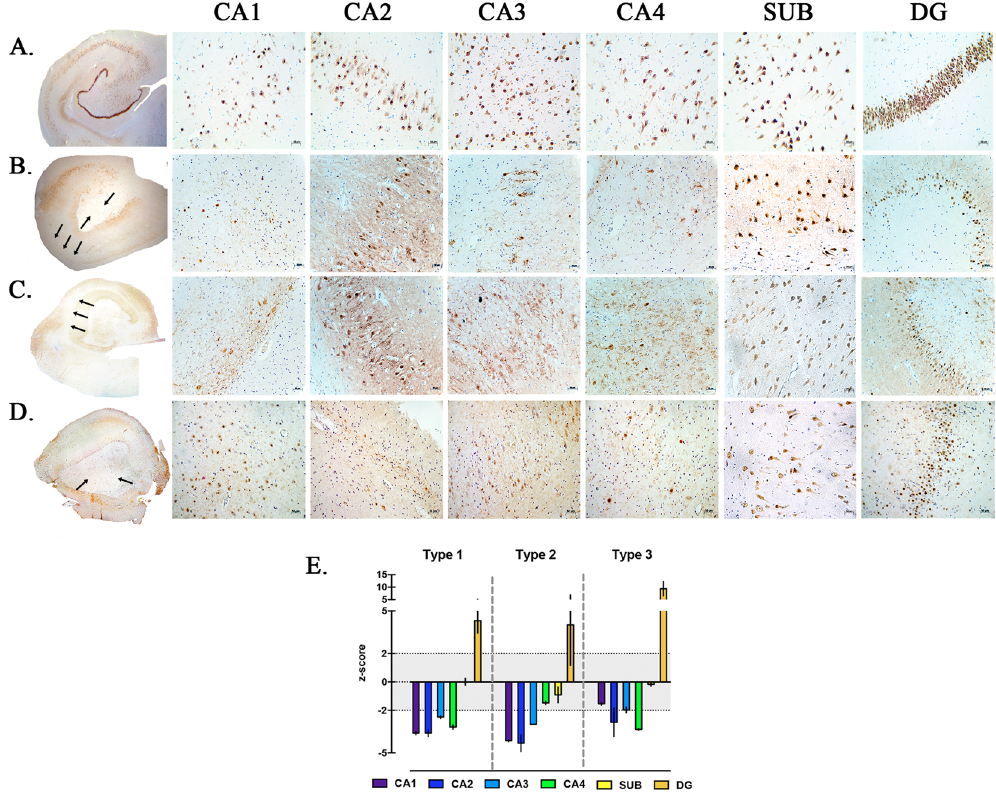
Figure 3. Histopathological patterns of hippocampal sclerosis. ( A – D ) NeuN immunostaining of neuronal nuclei. ( A ) No hippocampal sclerosis in control specimen obtained from autopsy without neurological disease. ( B ) ILAE hippocampal sclerosis type 1, note the marked neuronal loss in both the CA1 and CA4 subfields. ( C ) ILAE hippocampal sclerosis type 2, predominant cell loss in the CA1 area. ( D ) ILAE hippocampal sclerosis type 3, most restrict neuronal loss in the CA4 sector. Among all hippocampal sclerosis types, the histological pattern is variable in the dentate gyrus, wherein the granular cell loss and dispersion is predominant. Hippocampal subfields and the dentate gyrus were observed with a magnification of 20 × . Arrows indicate regions with severe neuronal loss. ( E ) Measurement of neuronal density in hippocampal subfields, neuronal cell counting was transformed into z-score using values from control hippocampi. Hippocampal sclerosis sectors were determined when cell neuronal counting was < than − 2 in z-score values. For the dentate gyrus, granular cell dispersion was considered when width reached > 2 in z-score